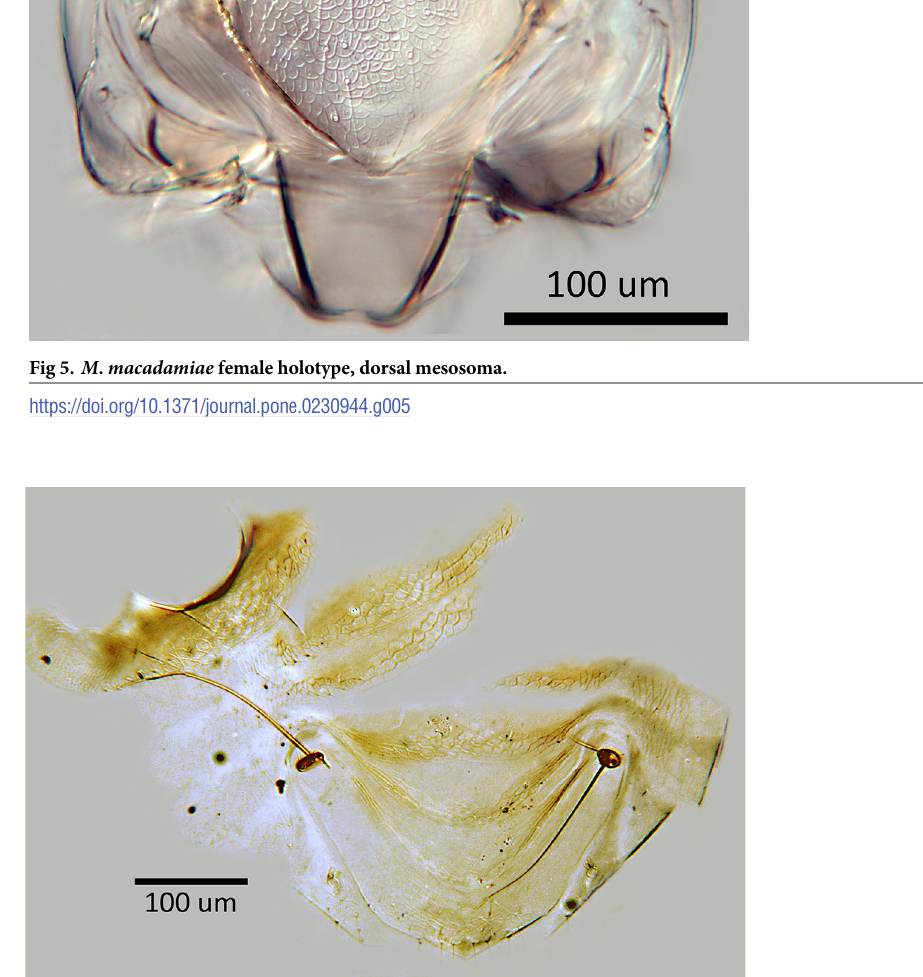
PLOS ONE | https://doi.org/10.1371/journal.pone.0230944 April 8,